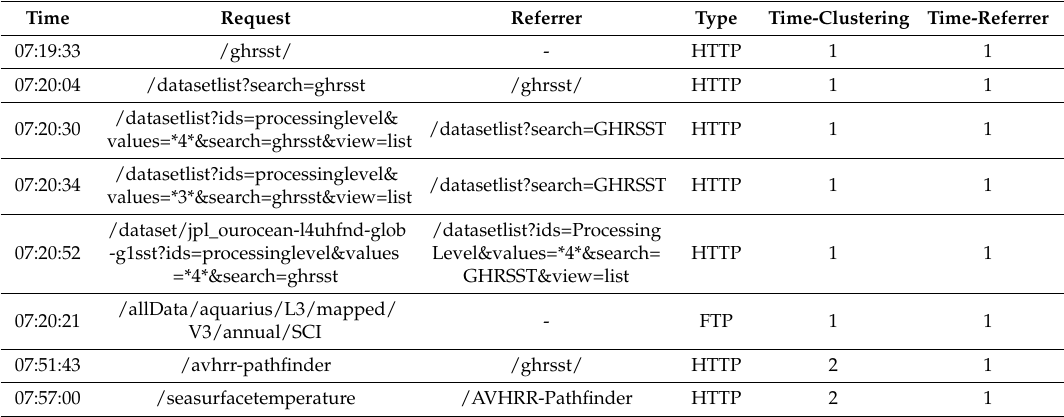
Table 4. Comparison of time-referrer-based and time-clusteirng-based heuristics.